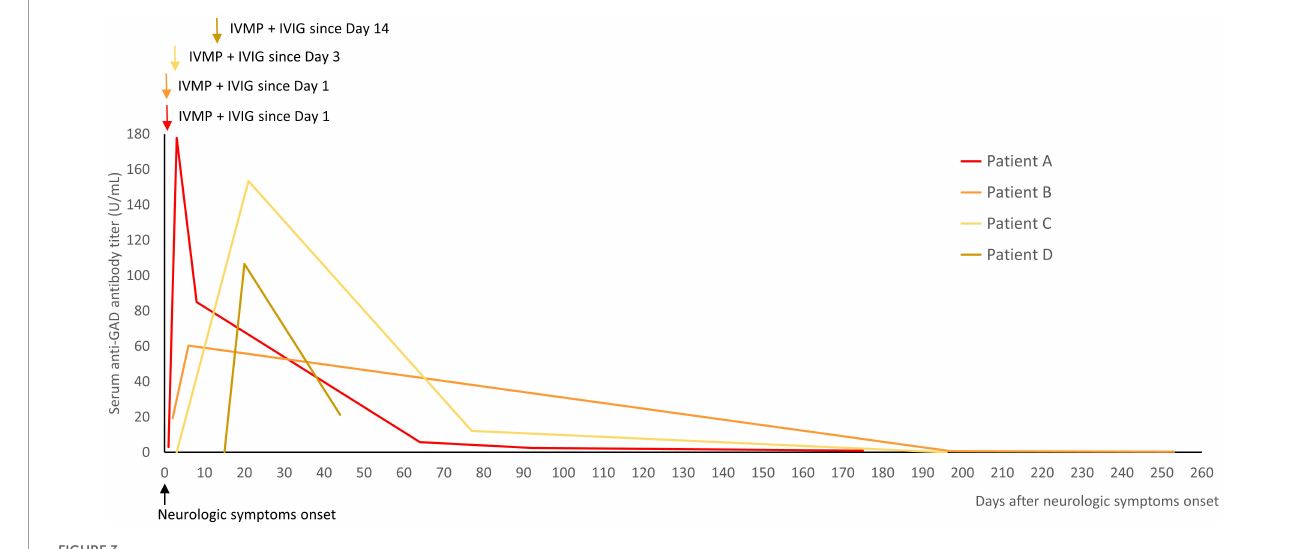
FIGURE3 Serial changes in the titers of serum anti-GAD antibodies during immunotherapy were measured in four patients. The titers were transiently elevated during immunotherapy, and then decreased after immunotherapy during follow-up. The arrows indicated the start of immunotherapy (IVMP and IVIG in all of them). GAD, glutamic acid decarboxylase; IVMP, intravenous methylprednisolone pulse therapy; IVIG, intravenous